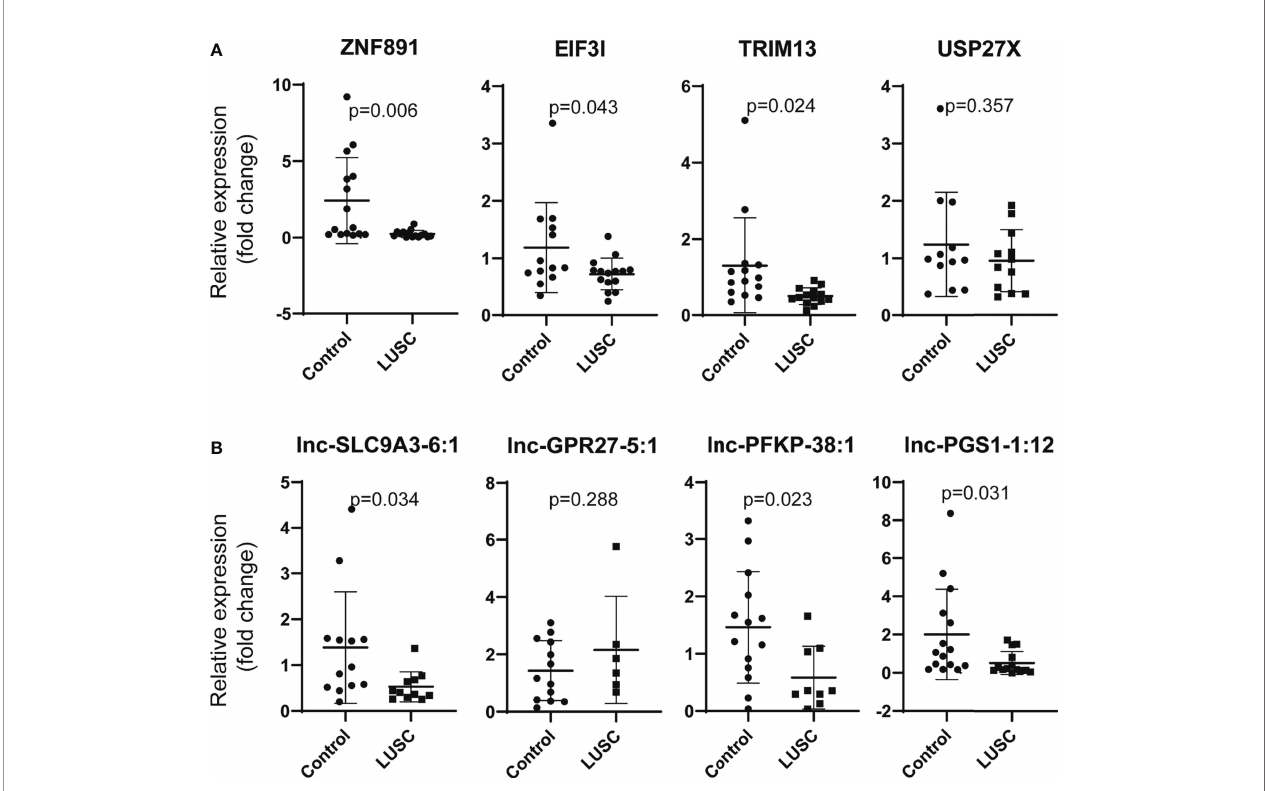
FIGURE 8 | Validation of the differentially mRNAs and lncRNAs in LUSC. (A) Validation of the differentially expressed mRNAs (ZNF891, ERCC4, ZNF33A and AFF2), (B) validation of the differentially expressed lncRNAs (lnc-FBXO33-2:3, lnc-ALB-1:6, lnc-DPH5-1:6, and LINC01376:1) (LUSC, lung squamous cell carcinoma; ZNF891, zinc fi nger protein 891; EIF3I, eukaryotic translation initiation factor 3, subunit I; TRIM13, tripartite motif containing 13, USP27X, ubiquitin speci fi c peptidase 27, X-linked; relative fold change of each sample was calculated using the mean GAPDH expression of control group as